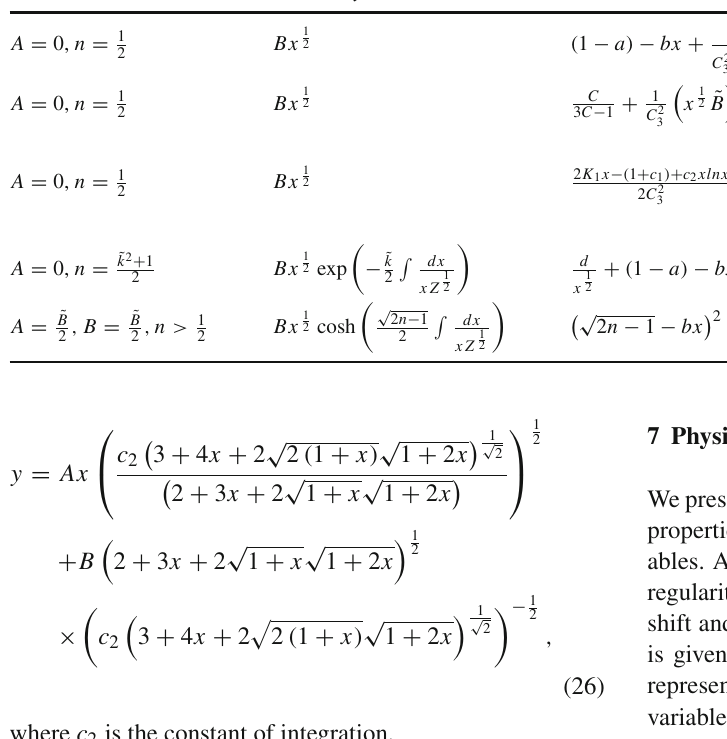
Table 3 Exact neutral anisotropic conformal symmetry solutions contained in our model